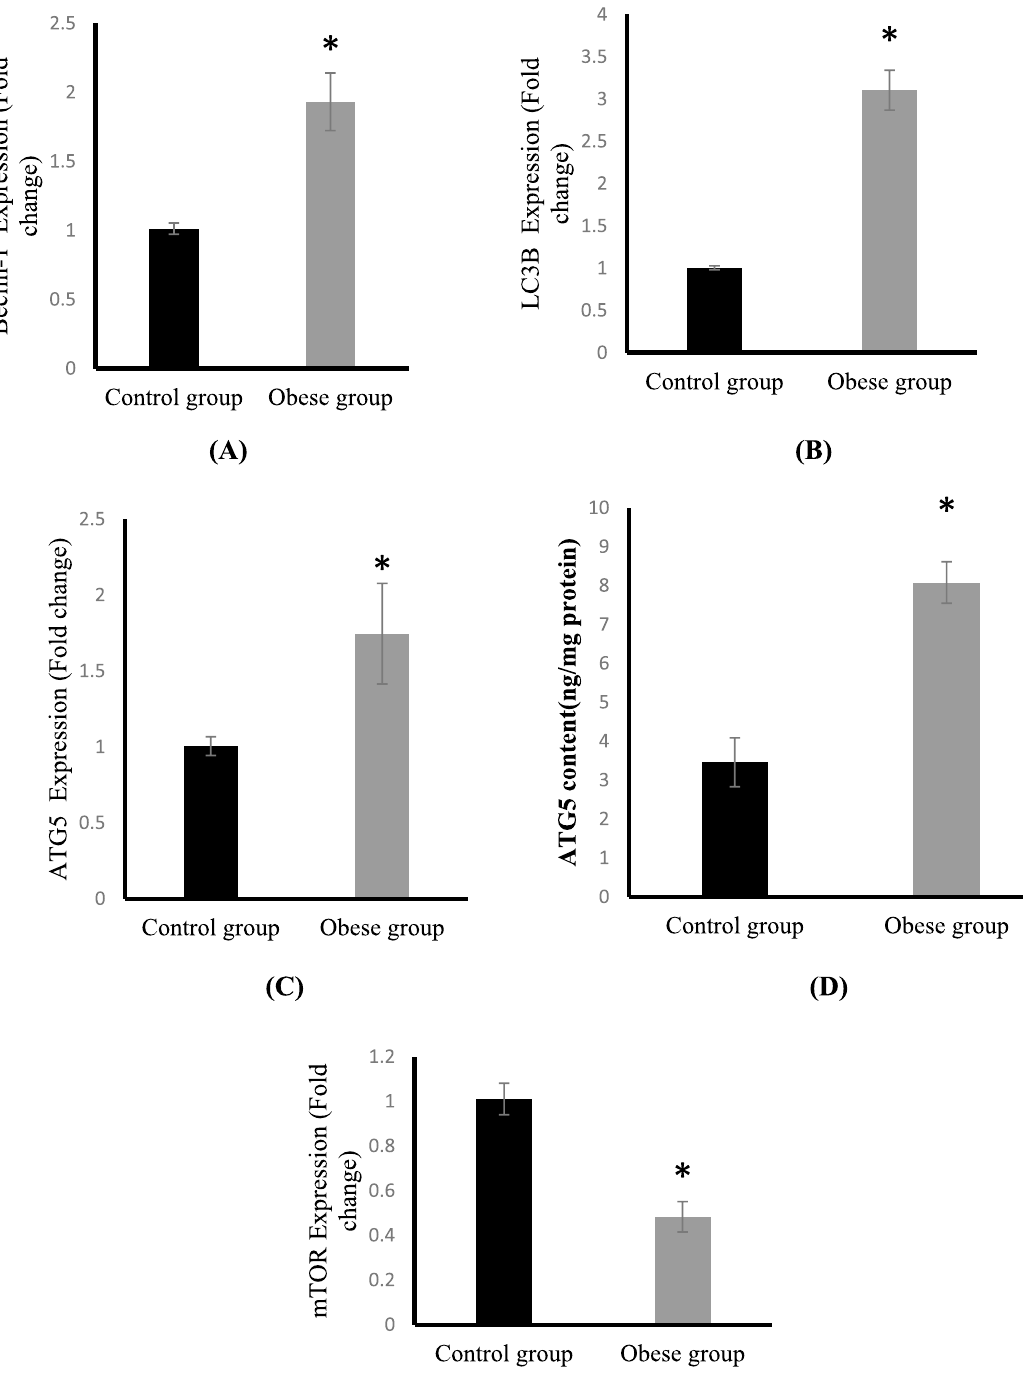
Figure 4. Cartilage mRNA expressions of Beclin-1 ( A ), LC3B ( B ), ATG5 ( C ), ATG5 protein levels ( D ) and mTOR expression ( E ) in the control and obese